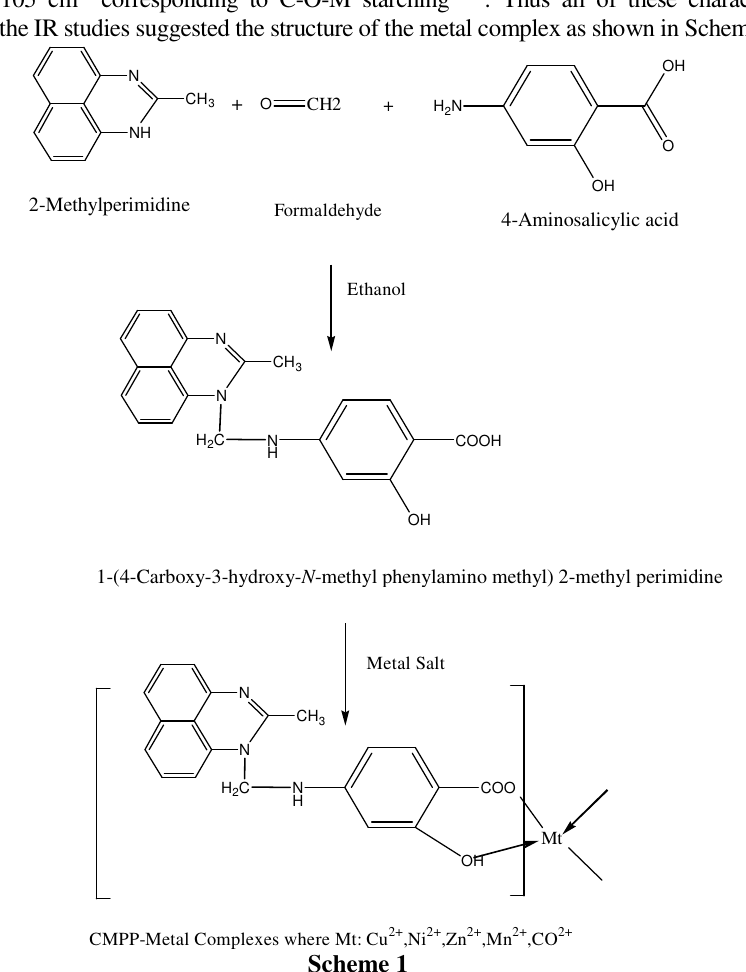
Examination of data of the metal content in each compound revealed a 1:2 metal:ligand (M:L) stoichiometry in all of the complex of divalent metal ions. Magnetic moment ( µ